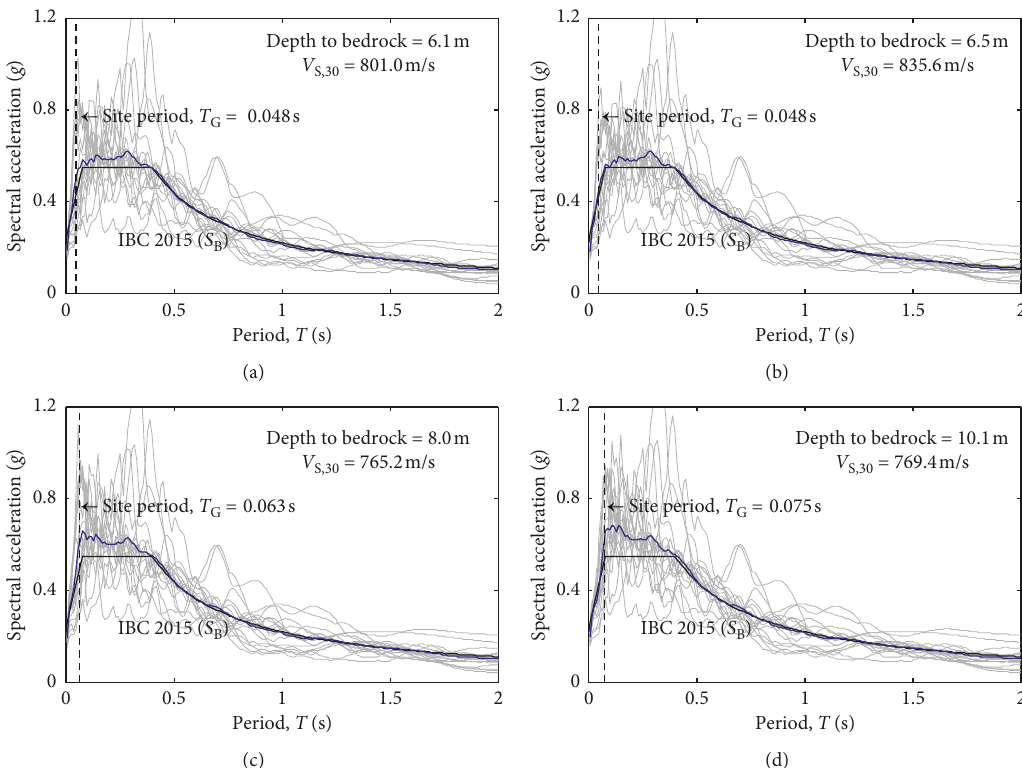
Figure 8: Response spectrum resulting from numerical analysis of four S